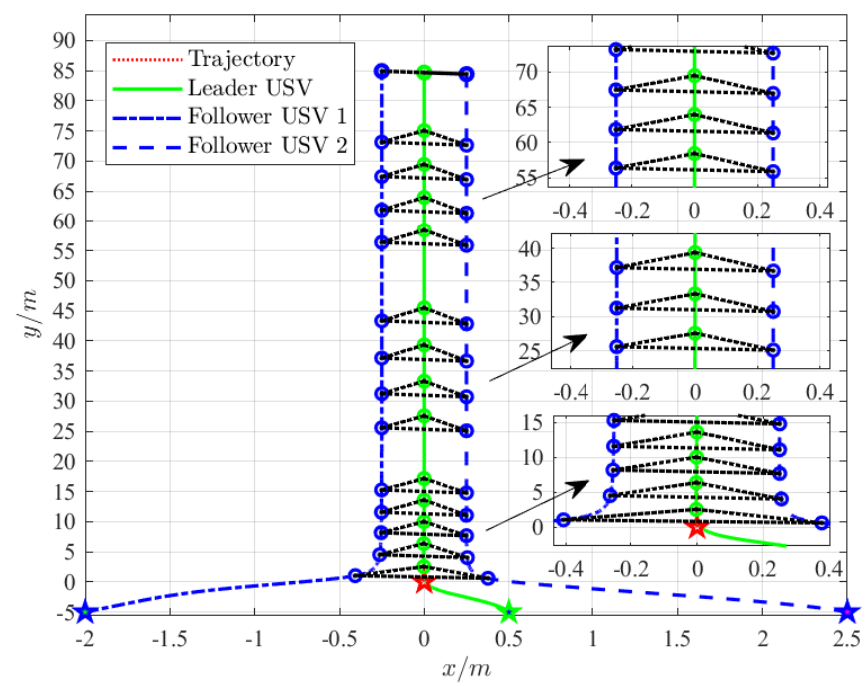
Figure 8. Triangular formation of USVs. The asterisk represents the start position of the